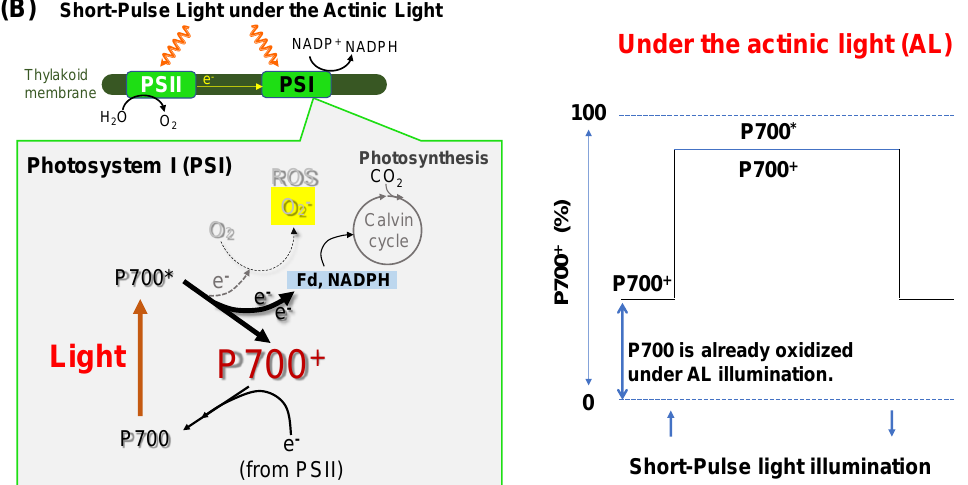
Figure 2. The kinetics of oxidized P700 during short-pulse (SP) illumination in the dark and under actinic light. ( A ) An SP illumination (20,000 µ mol photons m − 2 s − 1 , 400 ms) to intact leaves in the dark rapidly oxidizes the reaction center chlorophyll P700 in PSI from the fully reduced state to the maximally oxidized state. Afterwards, oxidized P700 (P700 + ) is reduced by electrons from PSII, with the accumulation of the excited state of P700 (P700*), as shown by the increase in shaded area. P700* can donate an electron to O 2 , thereby producing a superoxide radical (O 2 − ) through the one-electron reduction by the electron carriers, A 0 /A 1 , F x , and F A /F B , localized at the acceptor side of PSI. ( B ) In actinic light (AL) illumination, before SP illumination, P700 is already oxidized to P700 + . SP illumination further oxidizes P700 to its maximum, which is lower than the oxidation obtained in the dark, because P700* accumulates under the steady-state AL illumination. P700 + produced by SP illumination is not reduced, because P700 in PSI experiences turnover with the rate-determining step of P700 + reduction in the P700 photo-oxidation reduction cycle. The Y-axis shows the oxidation ratio of P700 from 0% to 100%, and the X-axis shows the time for SP illumination: upward arrow: SP illumination starts; downward arrow: SP illumination stops.